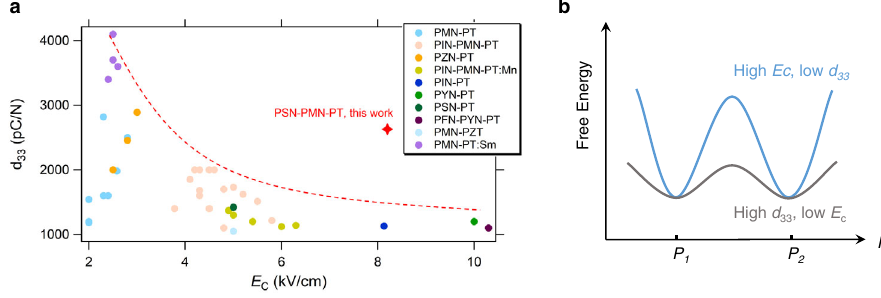
Fig. 1 Dilemma in ferroelectrics: enhanced E C is usually achieved at the expense of piezoelectricity. a d 33 vs. E C for various relaxor-PT single crystals. The red dashed line denotes the tendency of most relaxor-PT crystals. Generally, E C enhancement is accompanied by inferior piezoelectricity. Alternatively, our 0.06PSN – 0.61PMN – 0.33PT (red star) affords highly remarkable results. Data from refs. 9, 11, 17, 22, 31, 50 – 65 and this work. b Schematic of the different free energy landscapes and the corresponding macroscopic